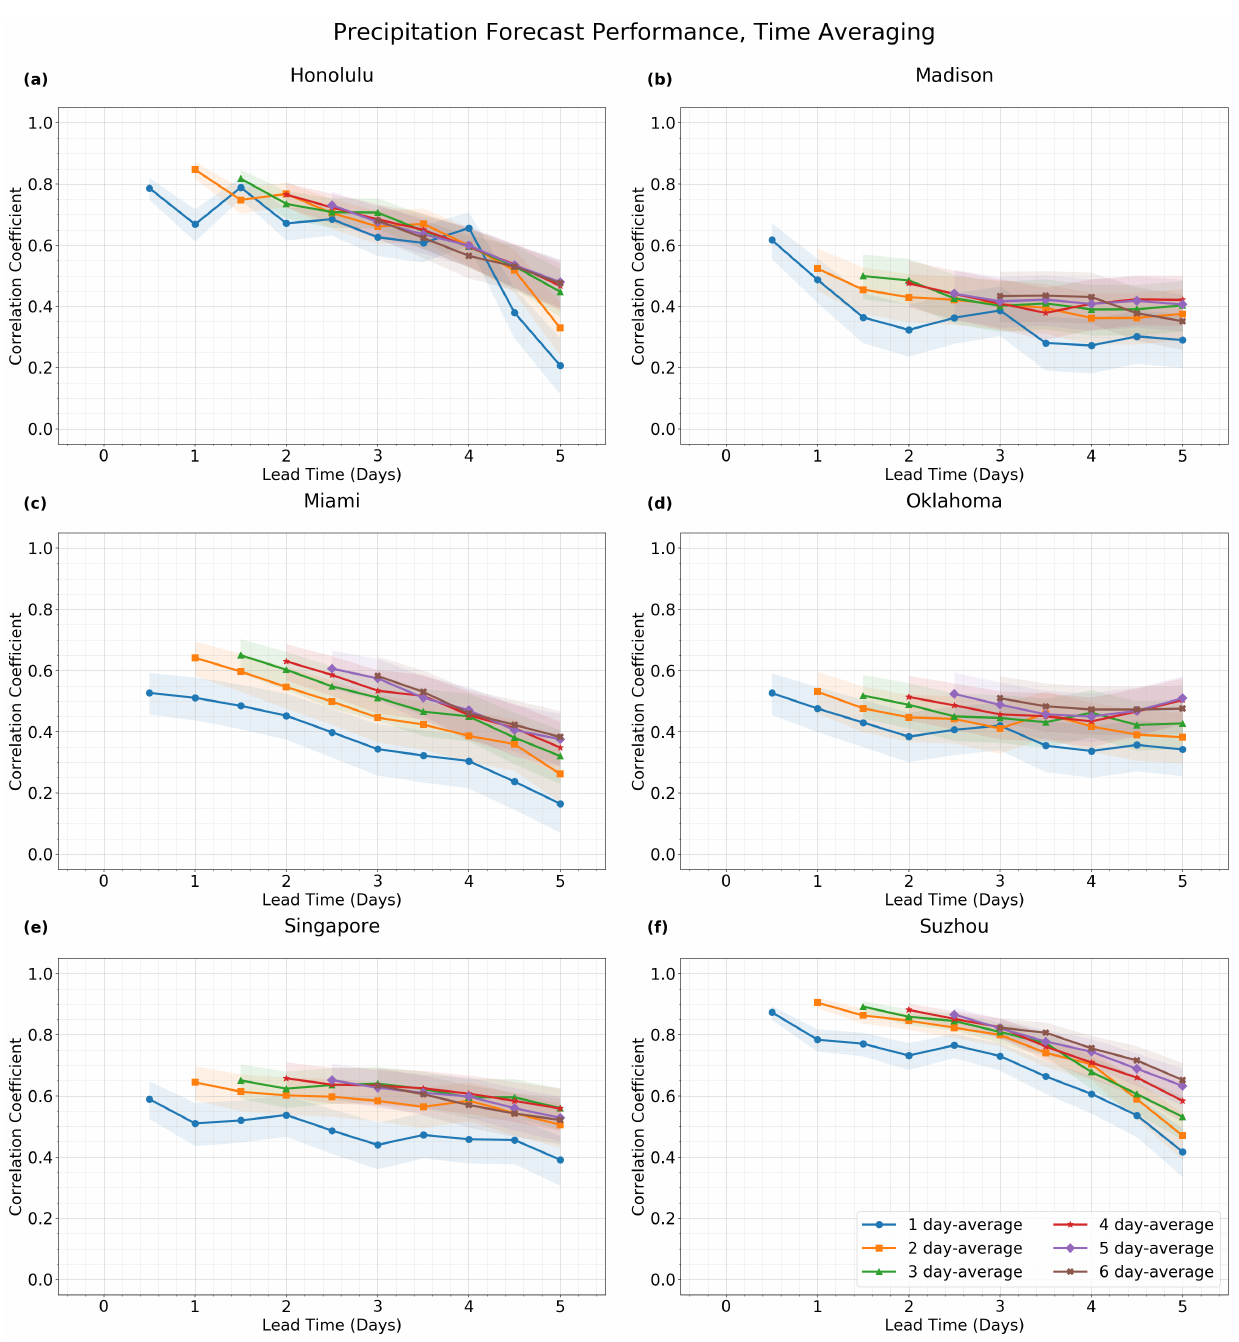
Figure 5. Effects of time averaging on forecast performance, for precipitation, with 100-km spatial averaging, at several locations around the globe: ( a ) Honolulu, Hawaii (21 ◦ N, 158 ◦ W), ( b ) Madison, Wisconsin (43 ◦ N, 89 ◦ W), ( c ) Miami, Florida (26 ◦ N, 80 ◦ W), ( d ) Oklahoma City, Oklahoma (35 ◦ N, 98 ◦ W), ( e ) Singapore (1 ◦ N, 104 ◦ E), and ( f ) Suzhou, China (31 ◦ N, 120 ◦ E). Compare to the effects of spatial averaging from Figure